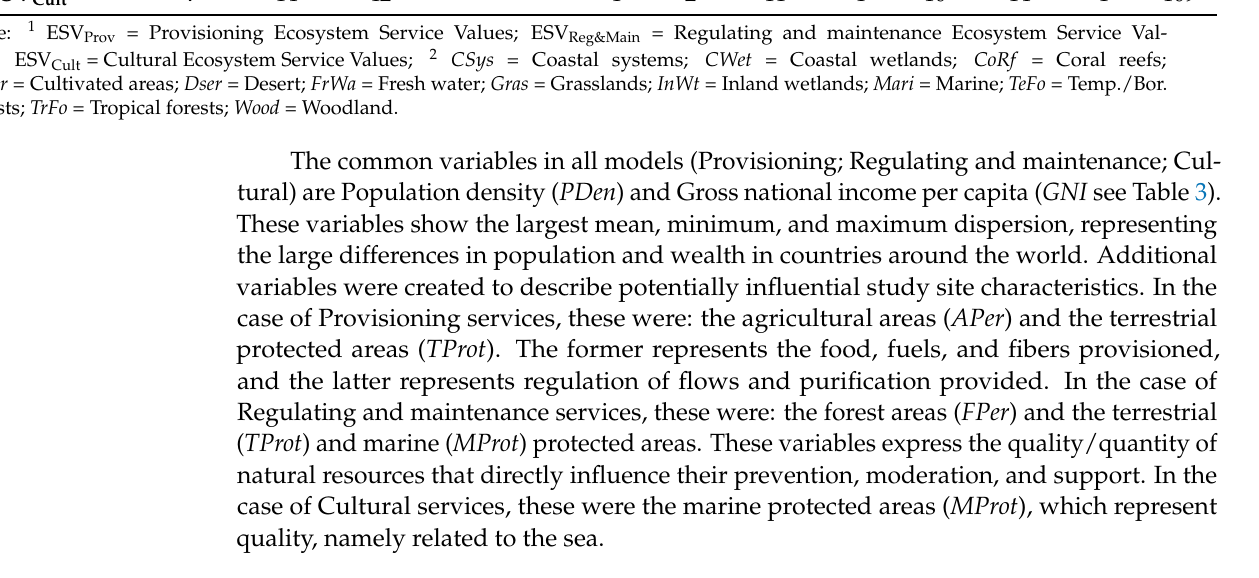
Table 2. Meta-analysis variables description.